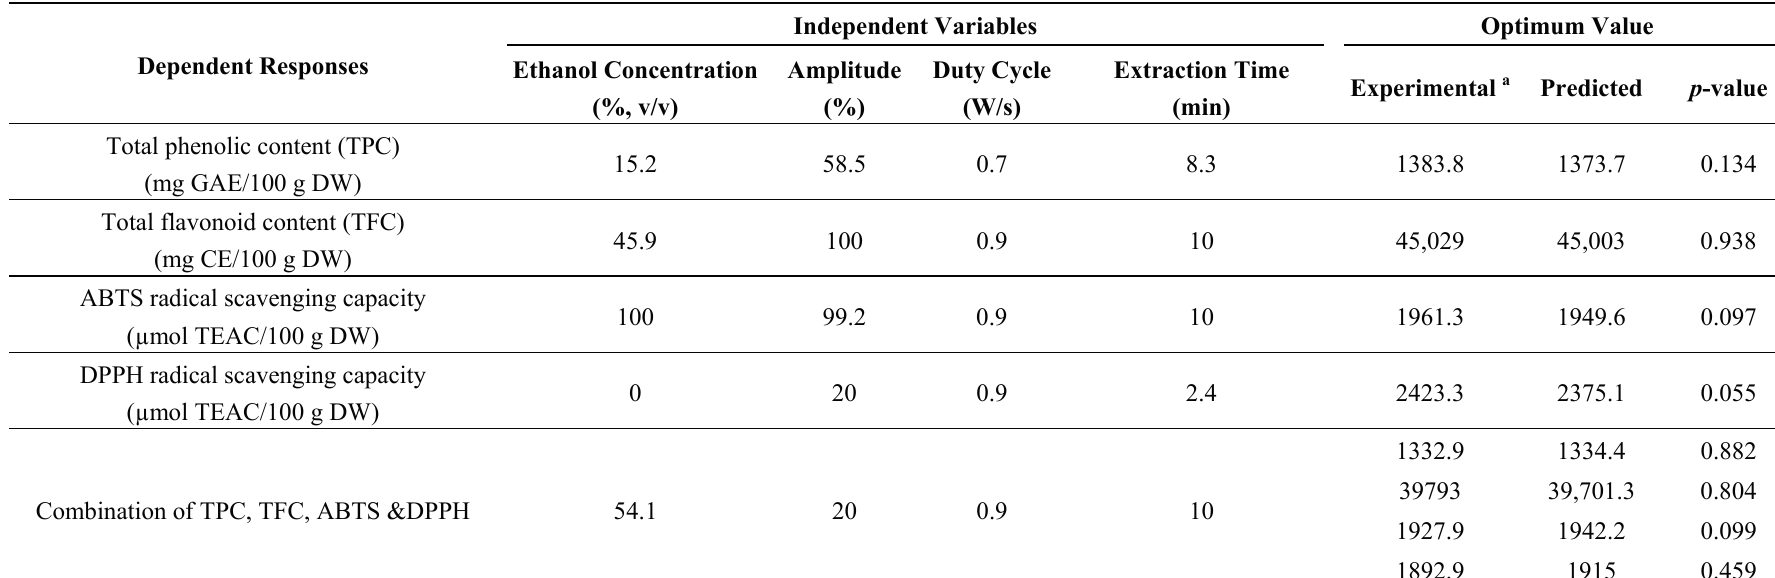
Table 3. Optimum conditions, predicted and experimental values of responses on ultrasound-assisted Orthosiphon stamineus